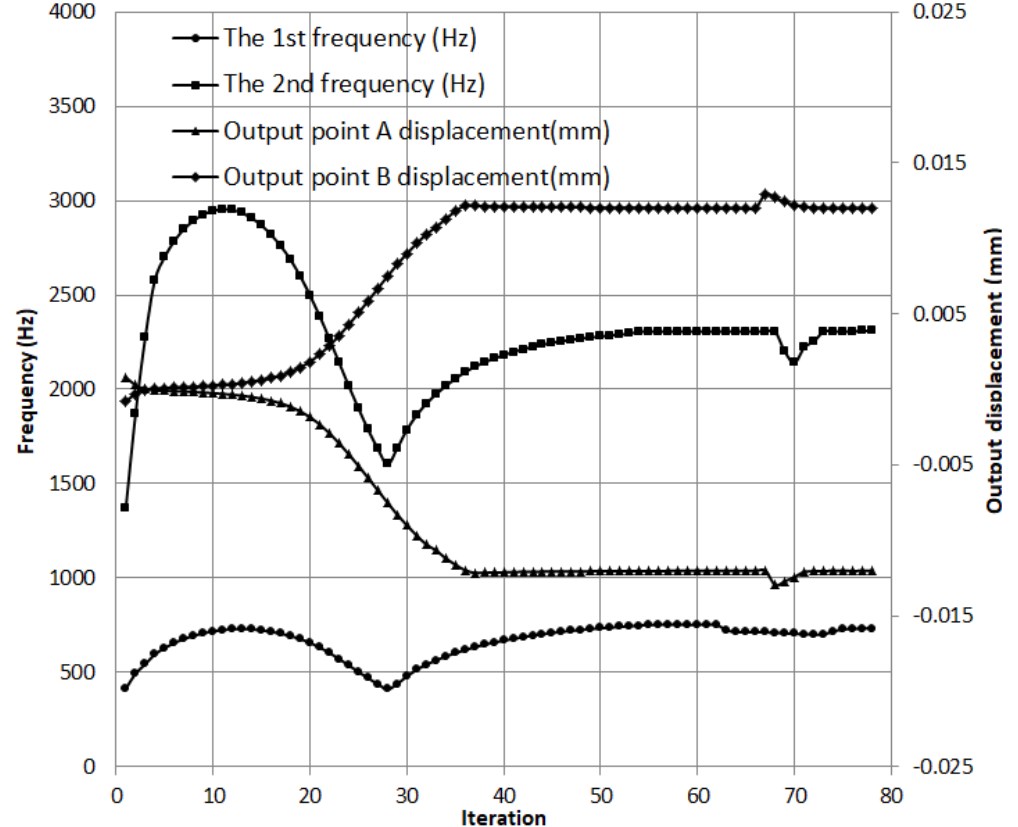
Figure 3. Convergence history of optimization for the gripper mechanism.